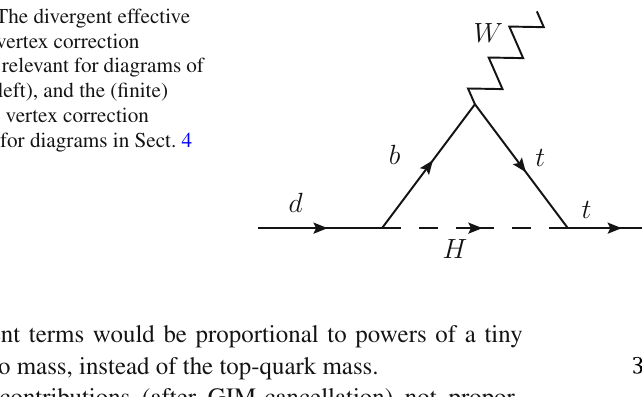
Fig. 7 The divergent effective W-loop vertex correction diagram relevant for diagrams of Sect. 3 (left), and the (finite) effective vertex correction relevant for diagrams in Sect. 4 (right)